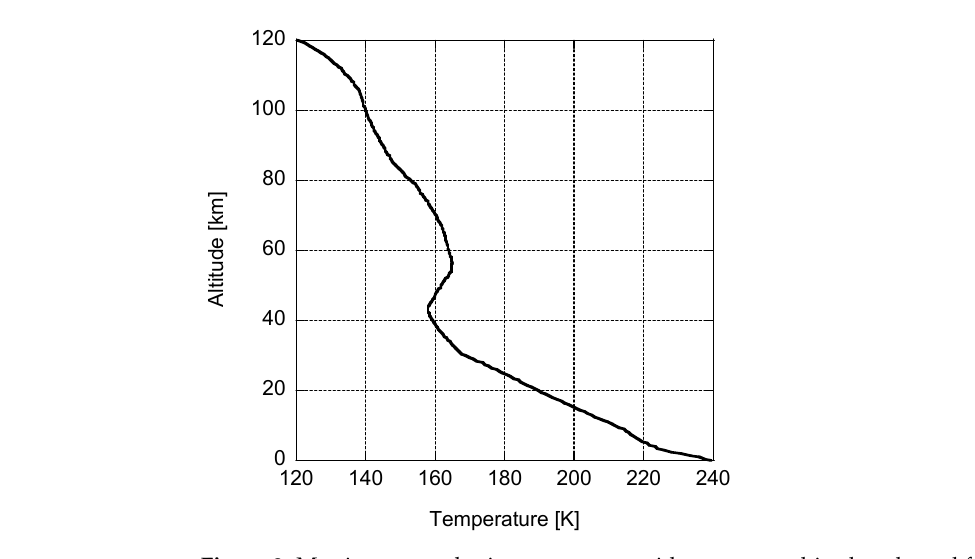
Figure 3. Martian atmospheric temperature with respect to altitude, adapted from [17]. The ratio of specific heats (k = c p /c v ) was calculated from constant pressure (c p ) and constant volume (c v ) parameters with c p fit to a second-order polynomial, based on data from Colonna et al. [19]: